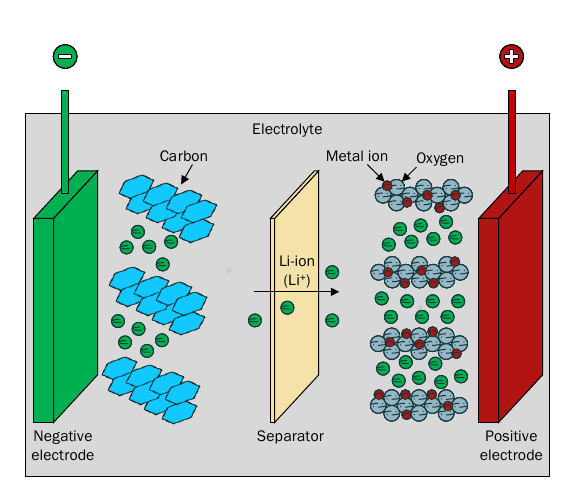
Figure 2. Typical configuration of the main components of a Li-ion